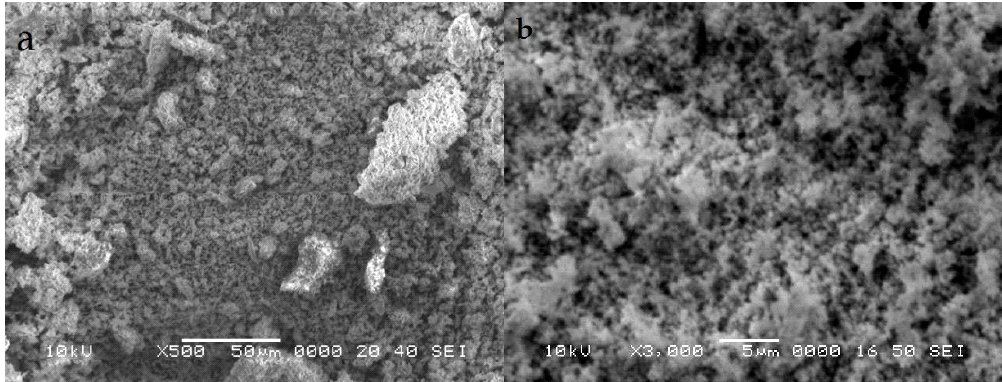
Figure 2. ( a , b ) SEM images of Rano-Cu NPs showing porous morphology with low and high magnification,